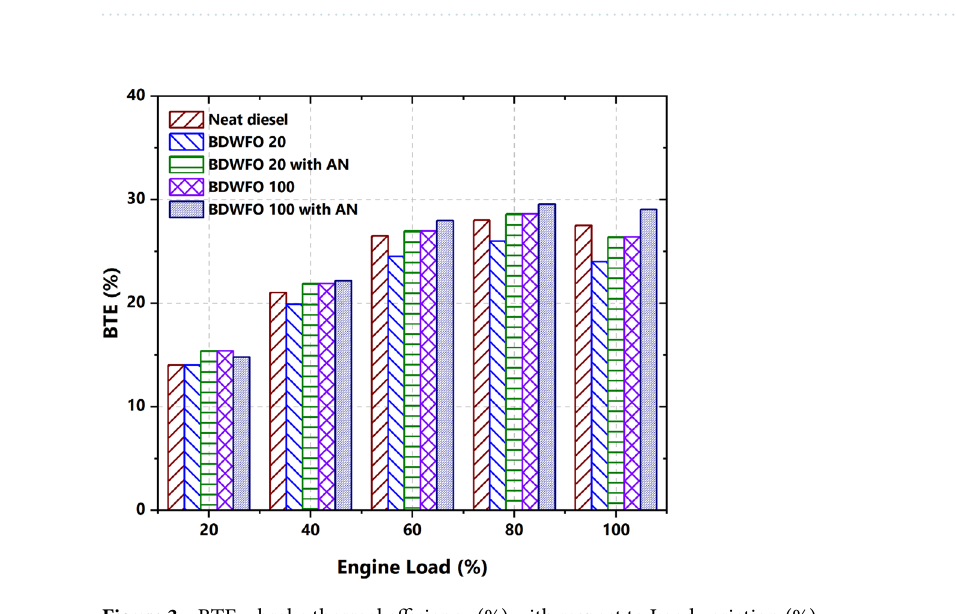
Table 6. Properties of diesel, biodiesel, and biodiesel with nanoparticles.